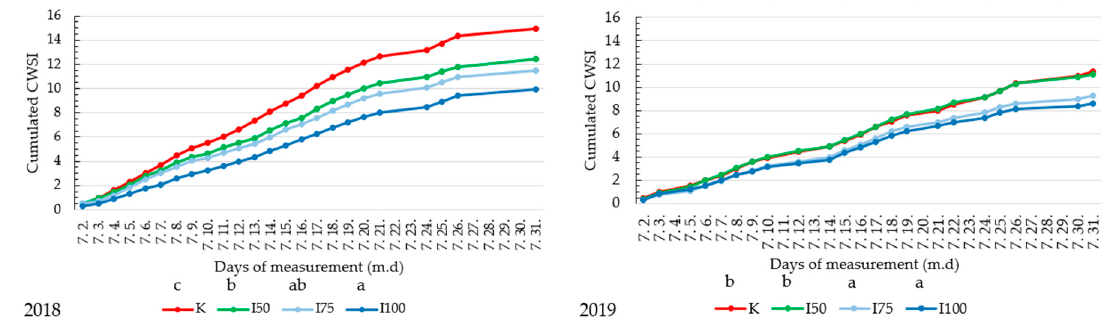
Figure 4. Trend of cumulated crop water stress index (CWSI) in the two years. Different letters above treatments in the legend represent statistical differences as a result of Tukey post hoc test ( p < 0.01).